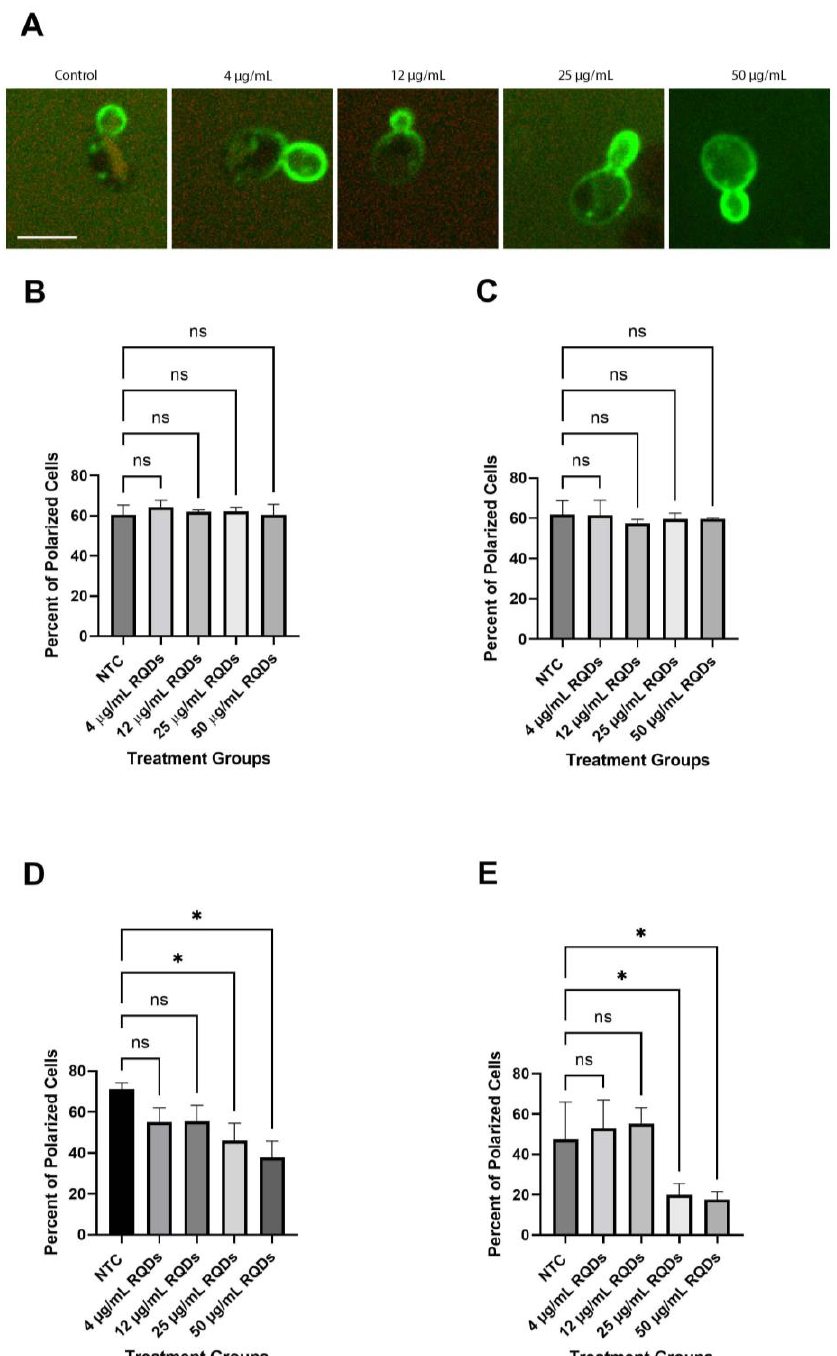
Figure 6. The distribution of GFP-Snc1 on the plasma membrane. For each, 30 cells were counted. The size bar is equivalent to 5 μ m. ( A ) Images of cells with different polarization at 6 h post-QD treatment. ( B ) The percentage of cells showed the polarized distribution of GFP-Snc1 on the plasma membrane for 1 h after treatment. ( C ) The percentage of cells showed the polarized distribution of GFP-Snc1 on the plasma membrane 3 h after treatment. ( D ) The percentage of cells showed the polarized distribution of GFP-Snc1 on the plasma membrane at 6 h after treatment. ( E ) The percentage of cells showed the polarized distribution of GFP-Snc1 on the plasma membrane at 24 h after treatment. * p < 0.05 .